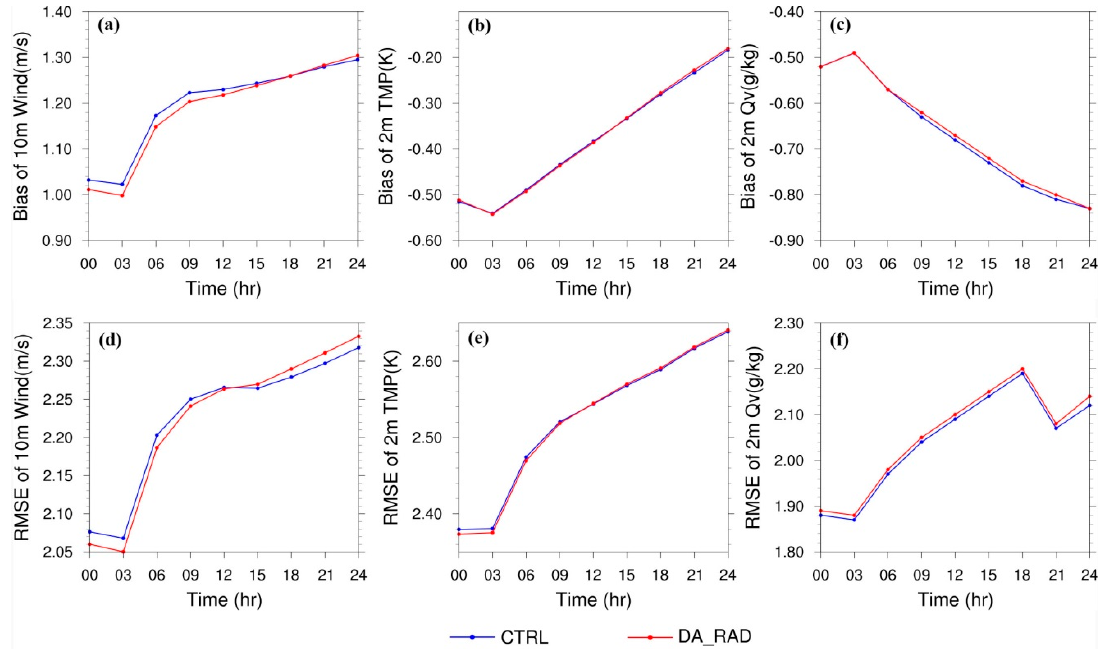
Figure 9. The average bias ( a – d ) and RMSE ( e – h ) of the vertical humidity (Qv: water vapor mixing ratio) profiles at hours 00, 06, 18, and 24 of the forecasts for retrospective runs (over the period of 1– 12 August 2017) without (CTRL) and with (DA_RAD) satellite radiances.